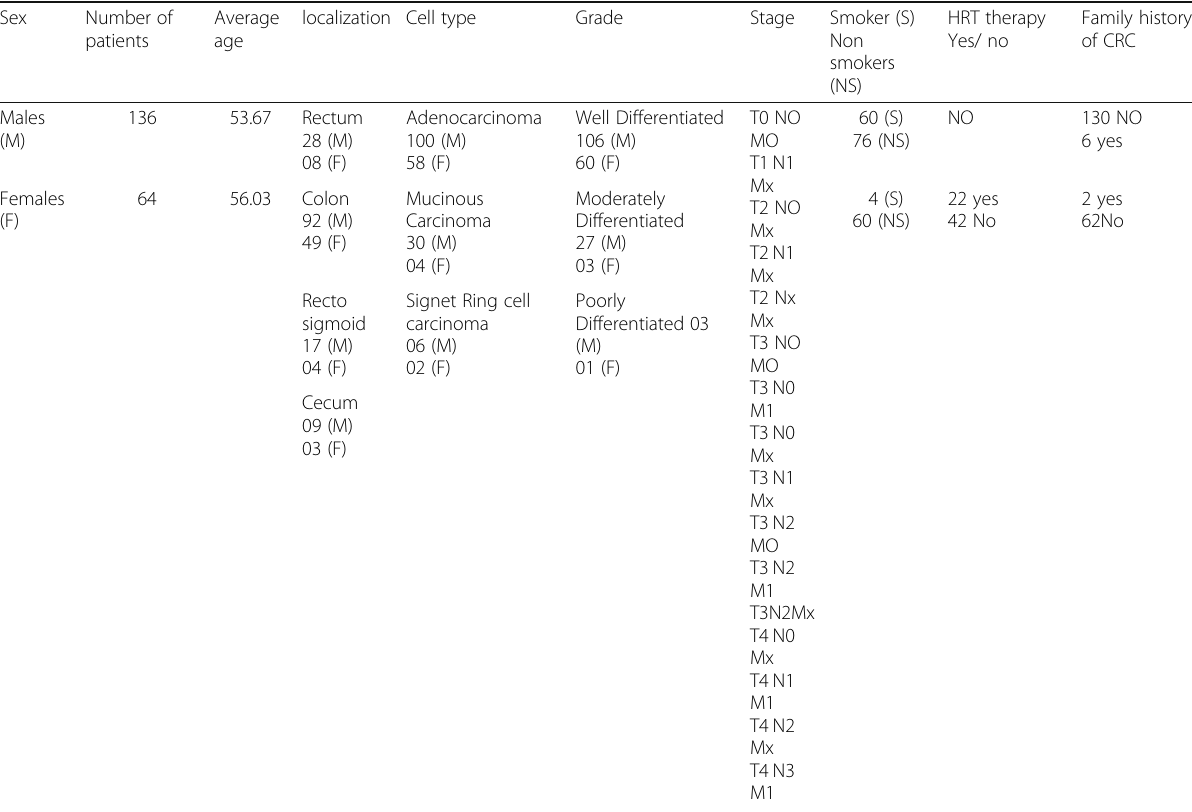
Table 1 Demographic and clinical data of colorectal cancer patients ( N = 200)